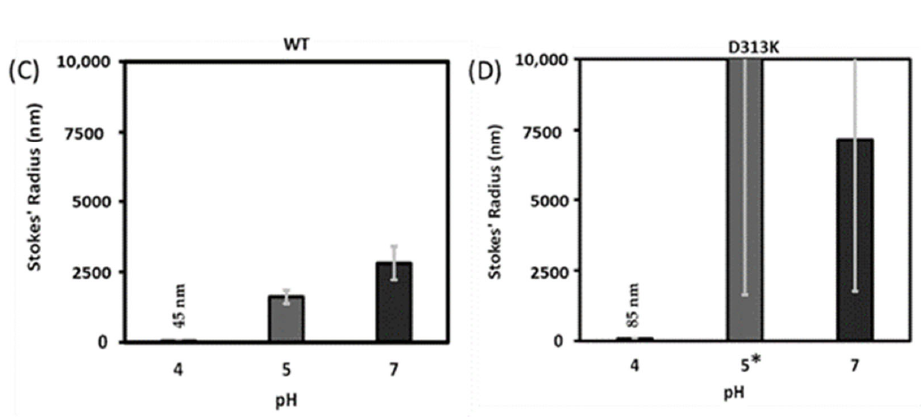
Figure 4. E ff ect of pH on low salt samples. ( A ) CD spectra of WT; ( B ) CD spectra of D313K; ( C ) hydrodynamic radii of WT (the Stokes radius at pH 4 is 45 ± 1 nm); and ( D ) hydrodynamic radii of D313K (the Stokes radius at pH 4 is 85 ± 15 nm). The asterisk indicates that the hydrodynamic radius at pH 5 extends o ff the graph to 17,800 nm. The WT samples contain 10 mM MgSO 4 while the D313K samples contain 10 mM NaCl. All data were recorded at ambient temperature.